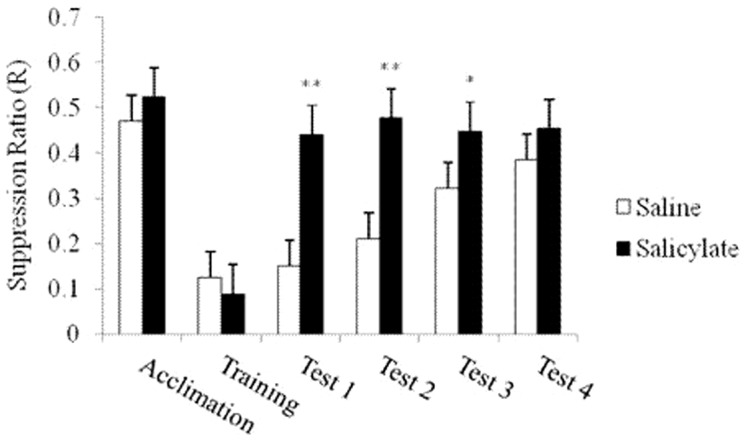
Changes of the suppression ratio (R) in different periods in the saline group and the salicylate group: “Acclimation” shows the average R of all rats in the saline or the salicylate group in the 2-day acclimation period; “Training” shows the average R of all rats in the saline or the salicylate group in the 7-day training period; Tests 1–4 show the 1st, 2nd, 3rd, and 4th day in the test period, respectively. Vertical bars represent mean ± standard error (SEM). **P<0.01 and *P<0.05 are compared with the saline group.